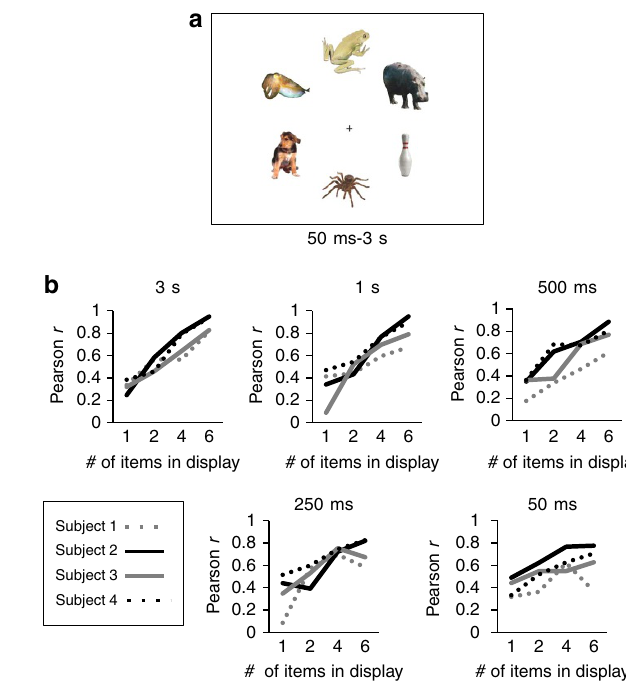
Figure 4 | Ensemble coding lifelikeness at different display durations. ( a ) Example display in Experiment 3. Participants viewed groups of up to six stimuli presented for 50ms to 3s, then rated the average lifelikeness of the group. ( b ) Participants consistently integrated multiple items across display